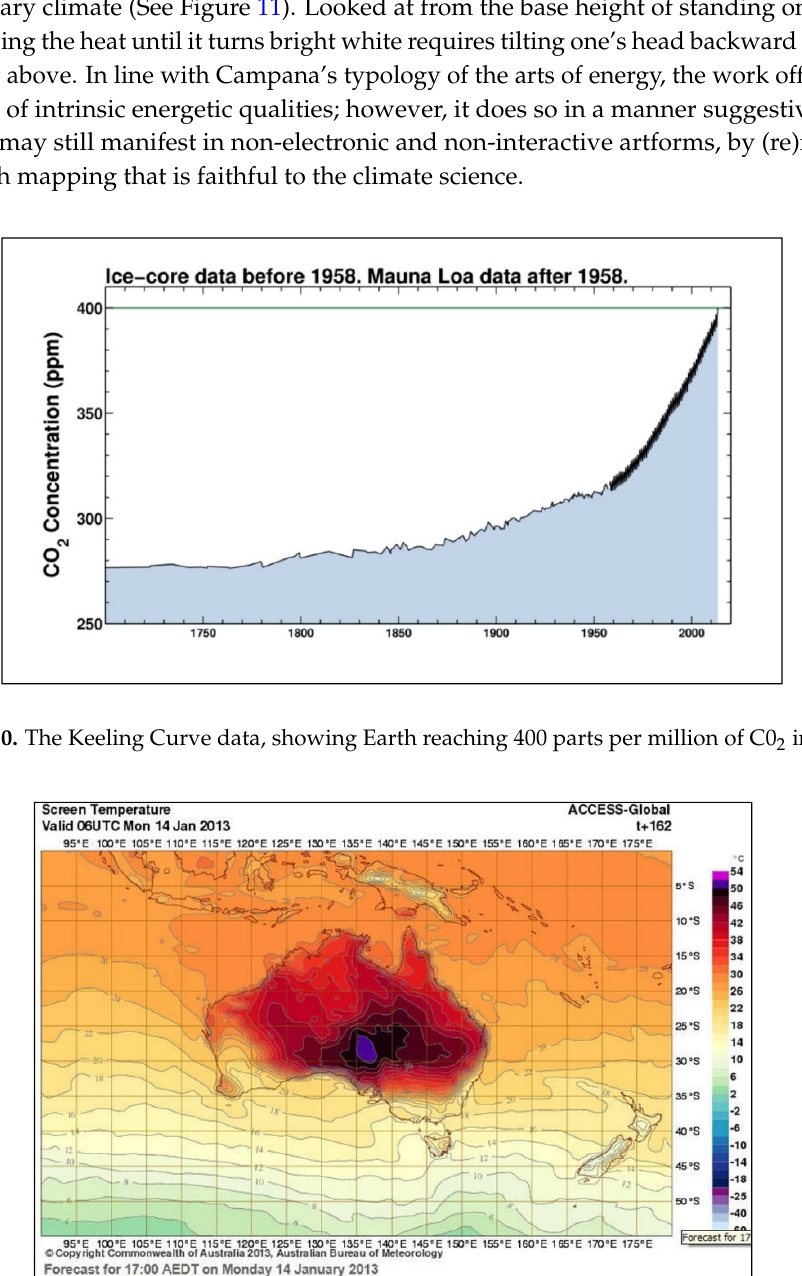
Figure 11. Heat map of Australia, showing the addition for the first time of new colours for 52° and 54°, 14 January 2013, Australia Bureau of Meteorology.